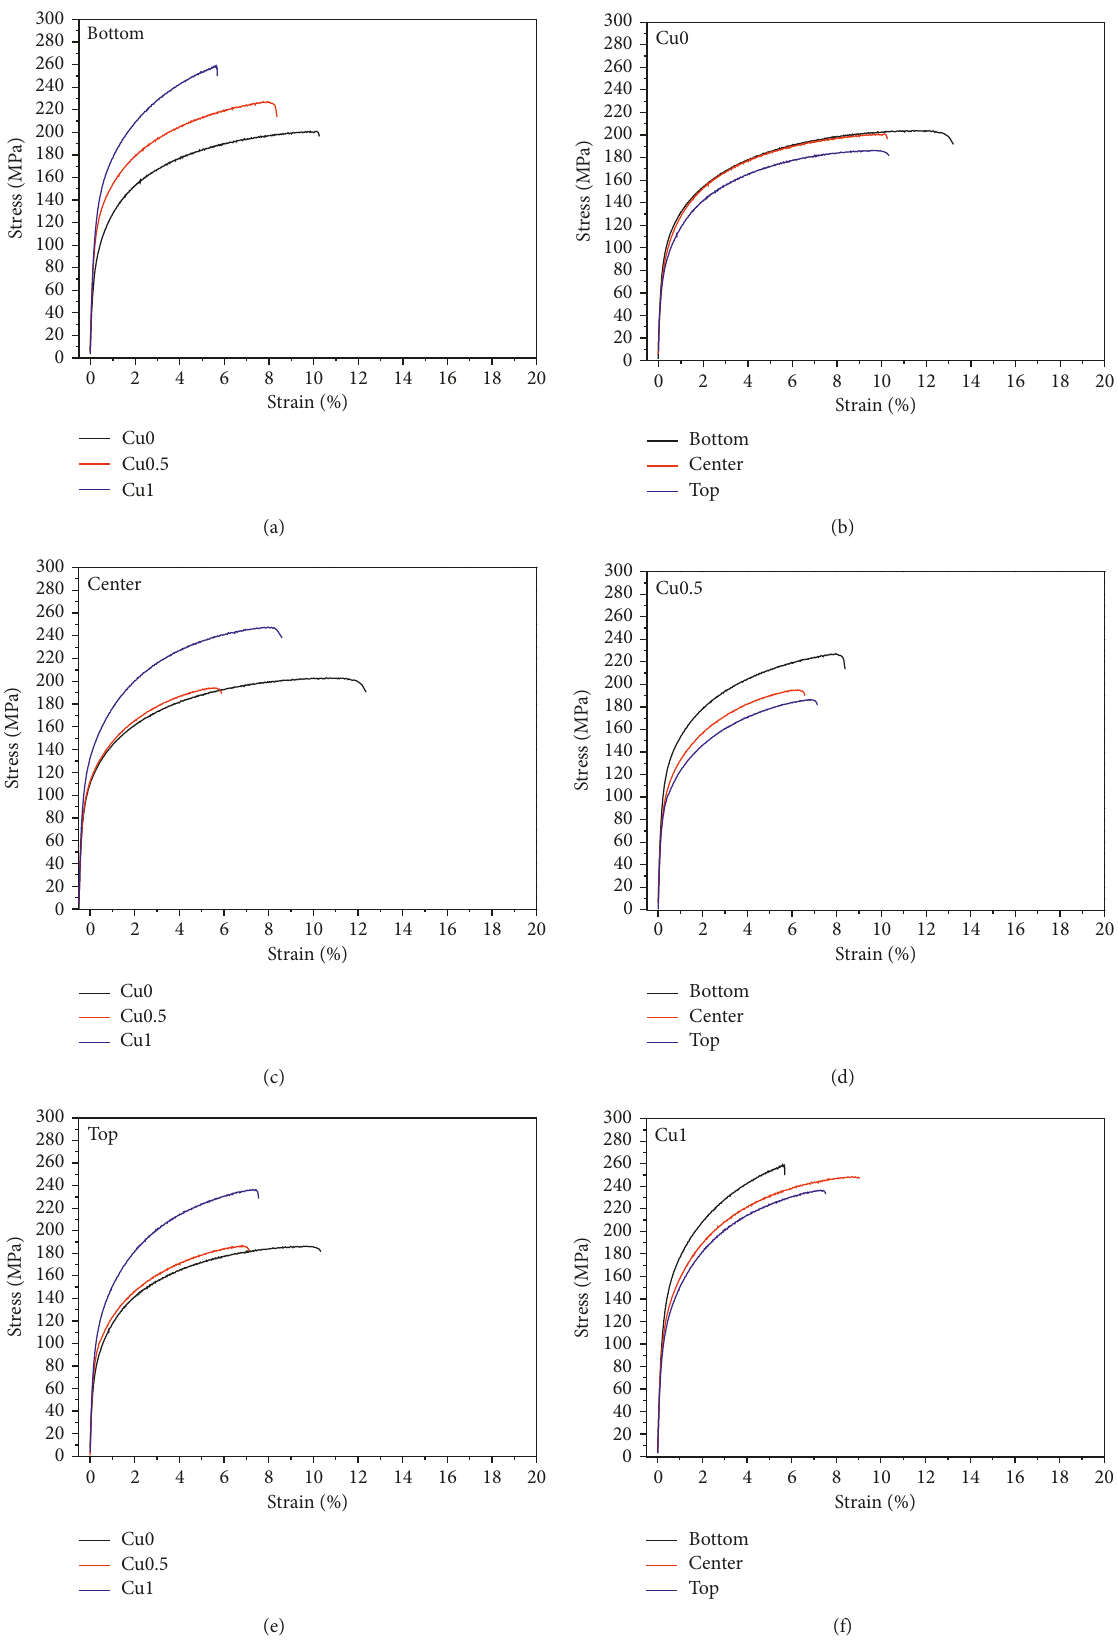
Figure 2: Tensilestrength-straincurvesof thethreeinvestigated alloys asa functionof bothCucontent(a,b,c)